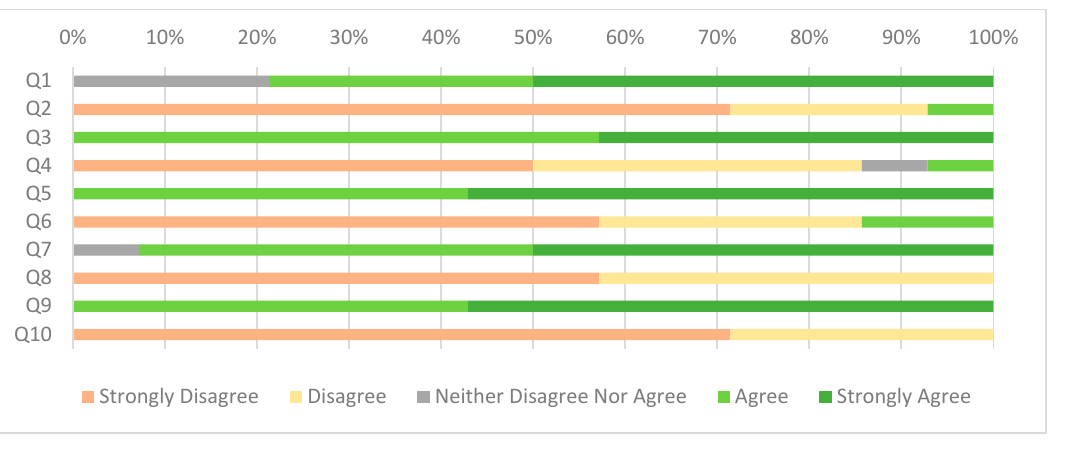
Figure 4. System Usability Scale Answers.